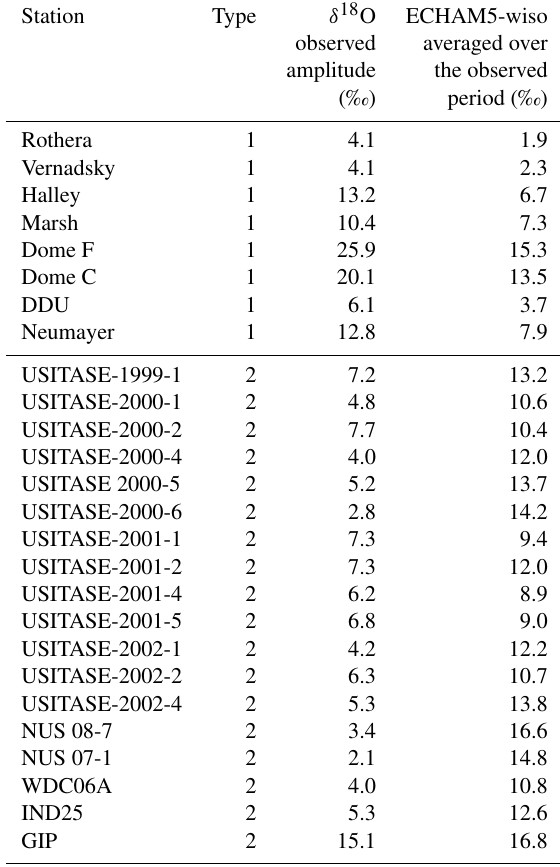
Table 4. δ 18 O mean seasonal amplitude (in ‰) calculated for pre- cipitation and sub-annual ice core data, as well as simulated by ECHAM5-wiso for the same time period as the data. The time res- olution used in the model corresponds to the time resolution of the precipitation data and to the annual scale for the ice core data (i.e. yearly averages based on daily precipitation isotopic composition weighted by the amount of daily precipitation). The data type is identified as 1 for precipitation samples and 2 for ice core data. Station Type